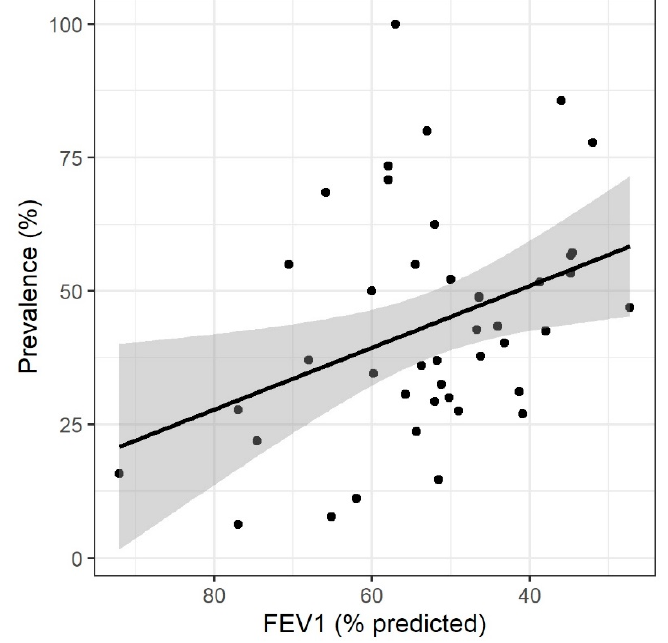
Figure 4. Scatterplot of bacterial colonization prevalence by declining mean or median FEV1 (% predicted). Each individual data point represents one study. Two studies (Bogaert 2004 and Jordan 1976) did not report FEV1 data, and as such are excluded here. R 2 = 0.136, p = 0.015. FEV1, forced expiratory volume in 1 s.